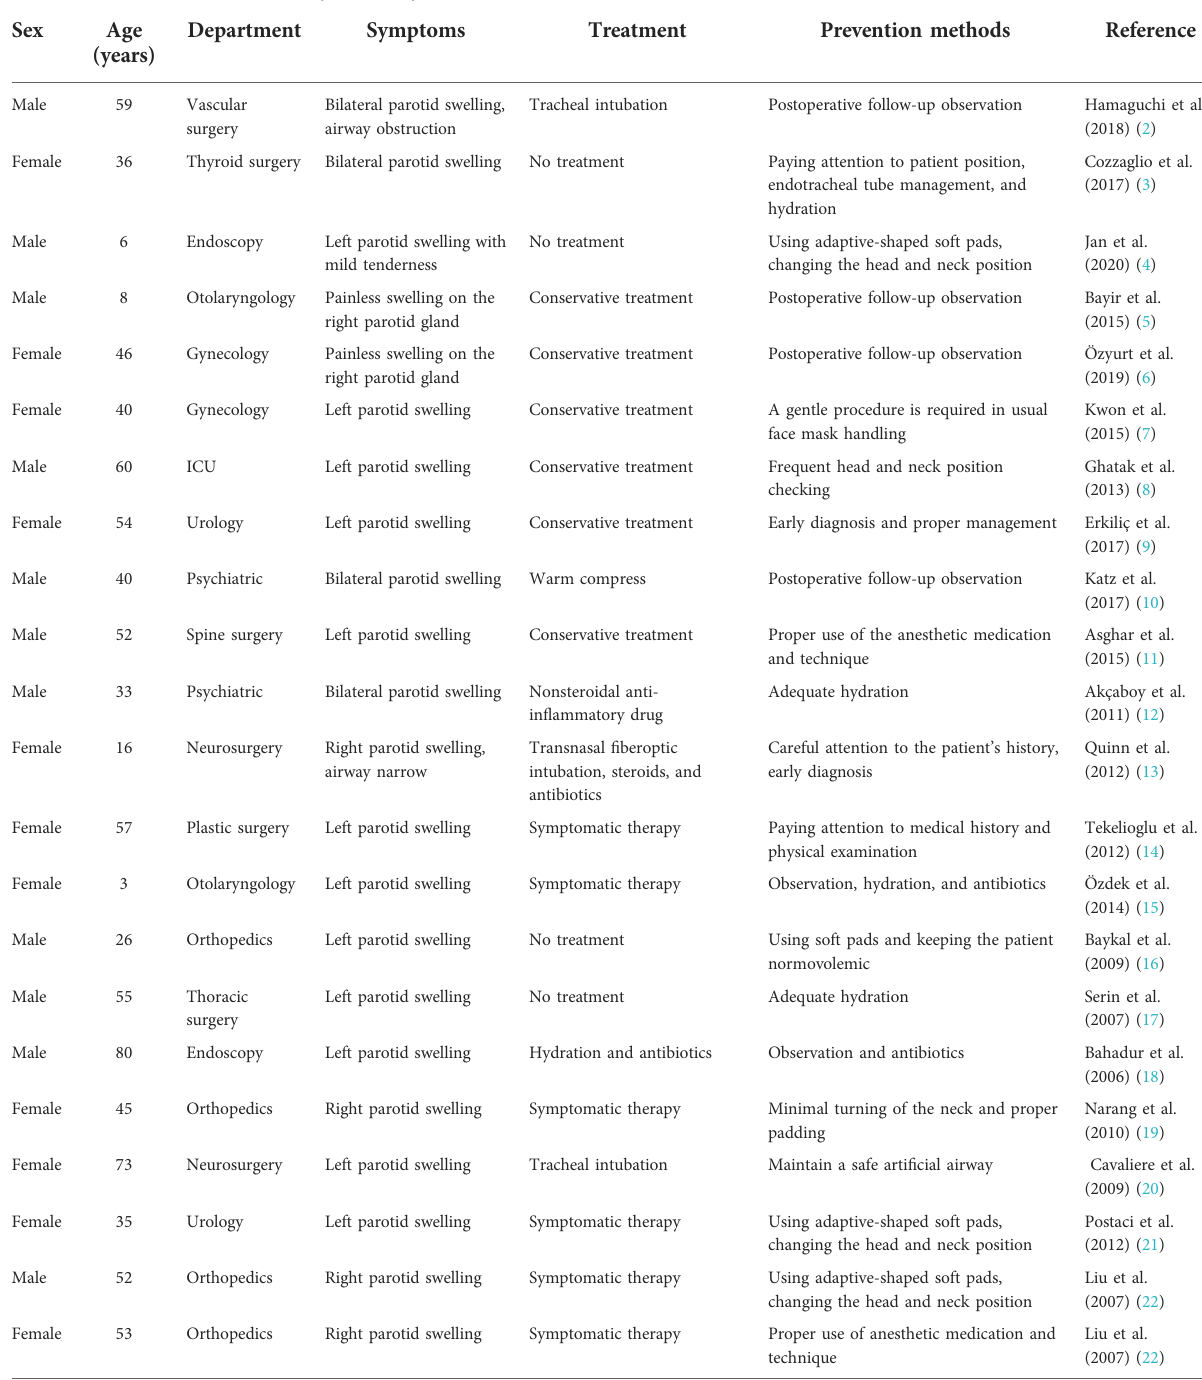
TABLE 1 A review of anesthesia mumps cases reported till